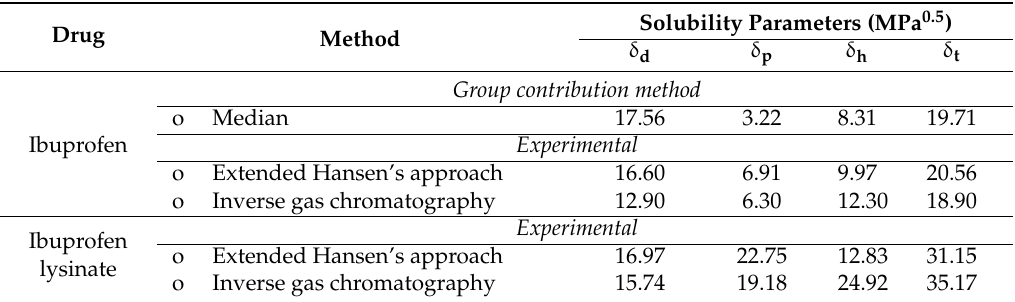
Table 6. The values of solubility parameters of ibuprofen and ibuprofen lysinate obtained by the calculation approach and by using experimental